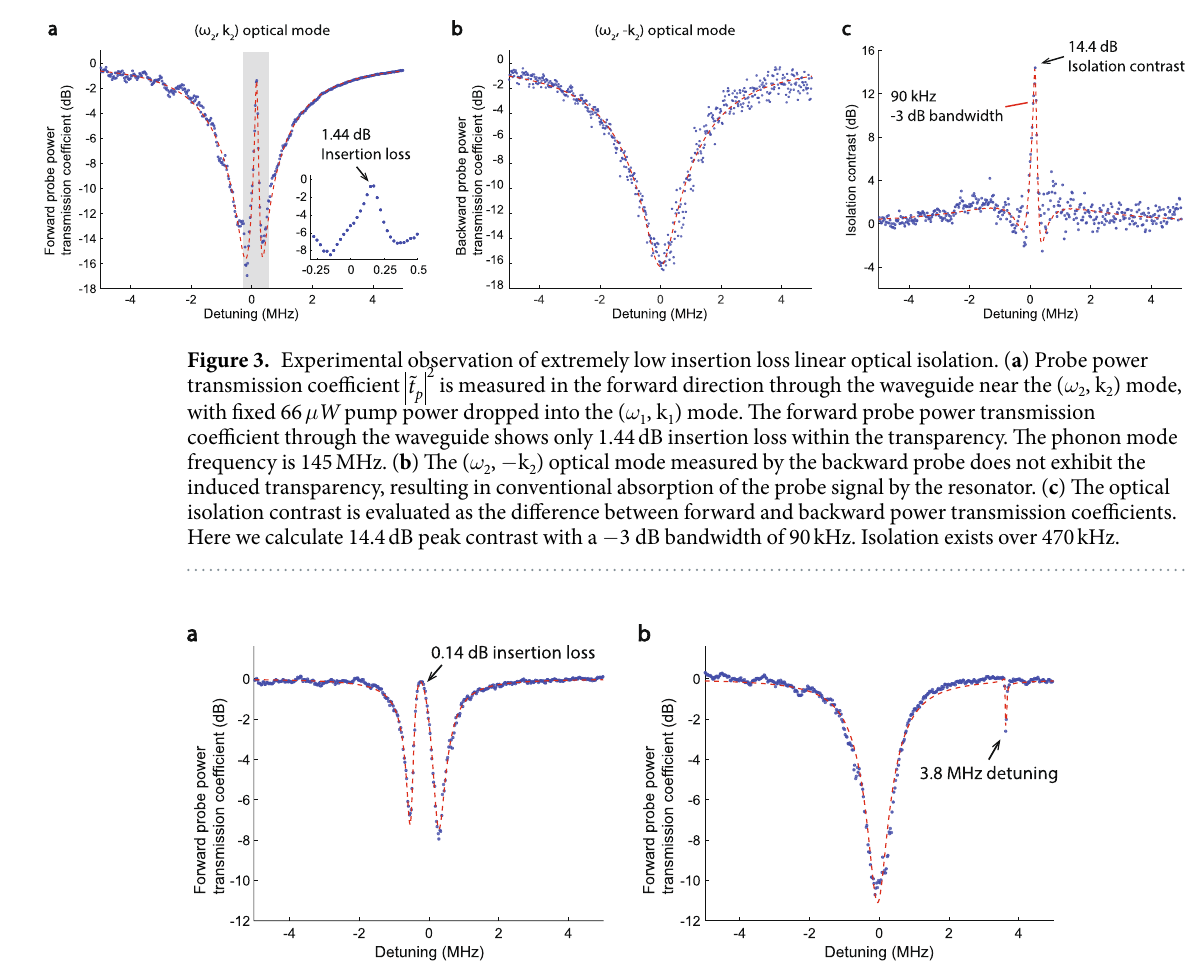
during the experiment, and vibrational or mechanical stability issues. Previously, up to 26 dB of signal extinction has been experimentally demonstrated in a fiber taper-microsphere system 37 . In the future, ideal isolation may be